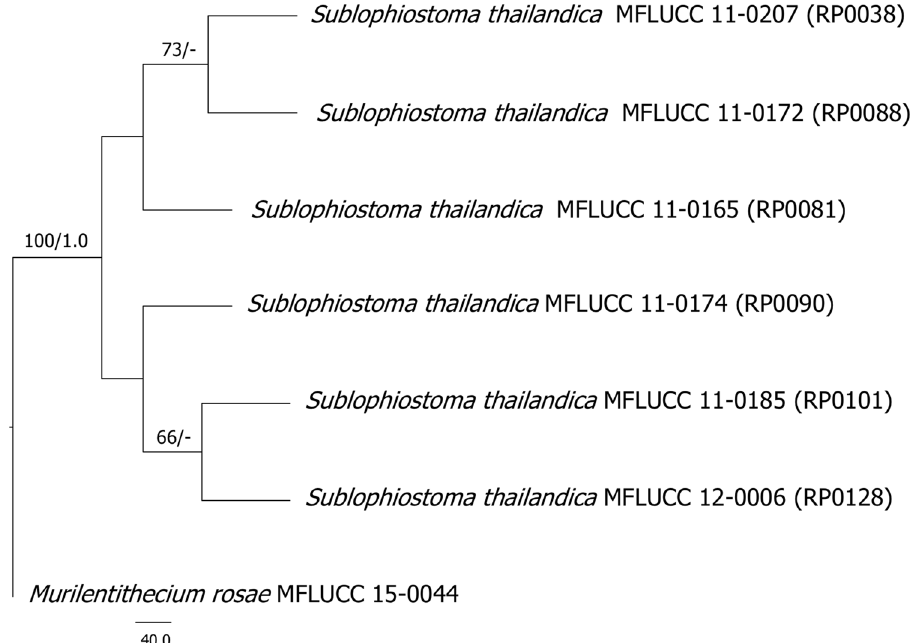
Figure 2. The first of 1,000 trees from maximum parsimony analysis of combined ITS, LSU, SSU, RPB2 and TEF sequence data for the species of Sublophiostoma . Maximum parsimony bootstrap support values (MP) equal or higher than 60% and Bayesian probability values (BYPP) equal to or above 0.90 are given at the nodes (MP/ BYPP). The tree is rooted to Murilentithecium rosae (MFLUCC